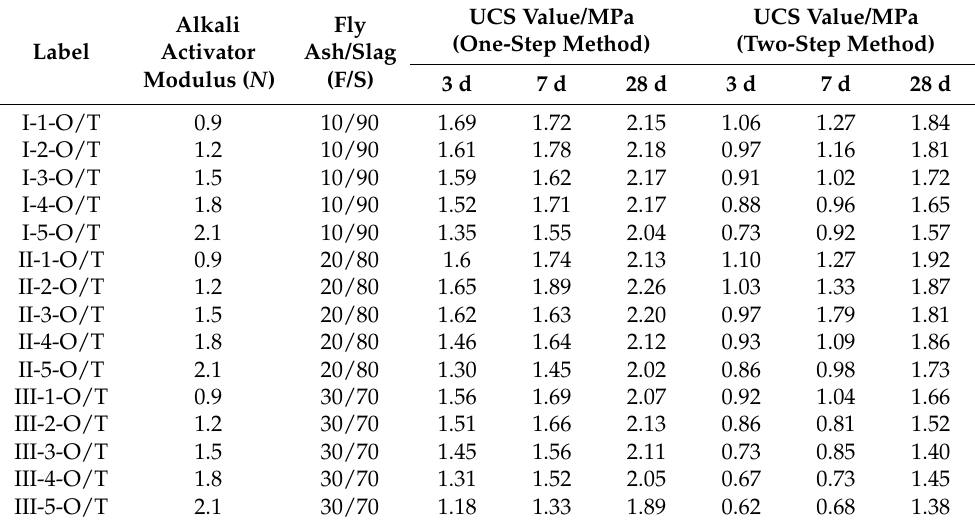
Table 3. 3, 7, 28 d UCS values of geopolymer-stabilized